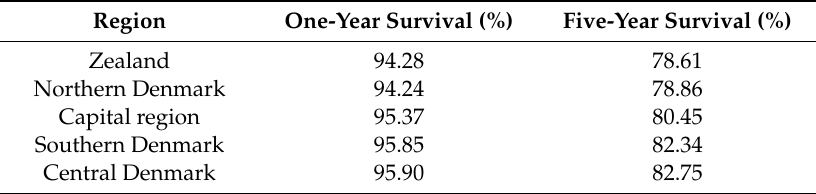
regions, for women diagnosed with breast cancer between 2008 and 2010, ordered by increasing five-year survival.